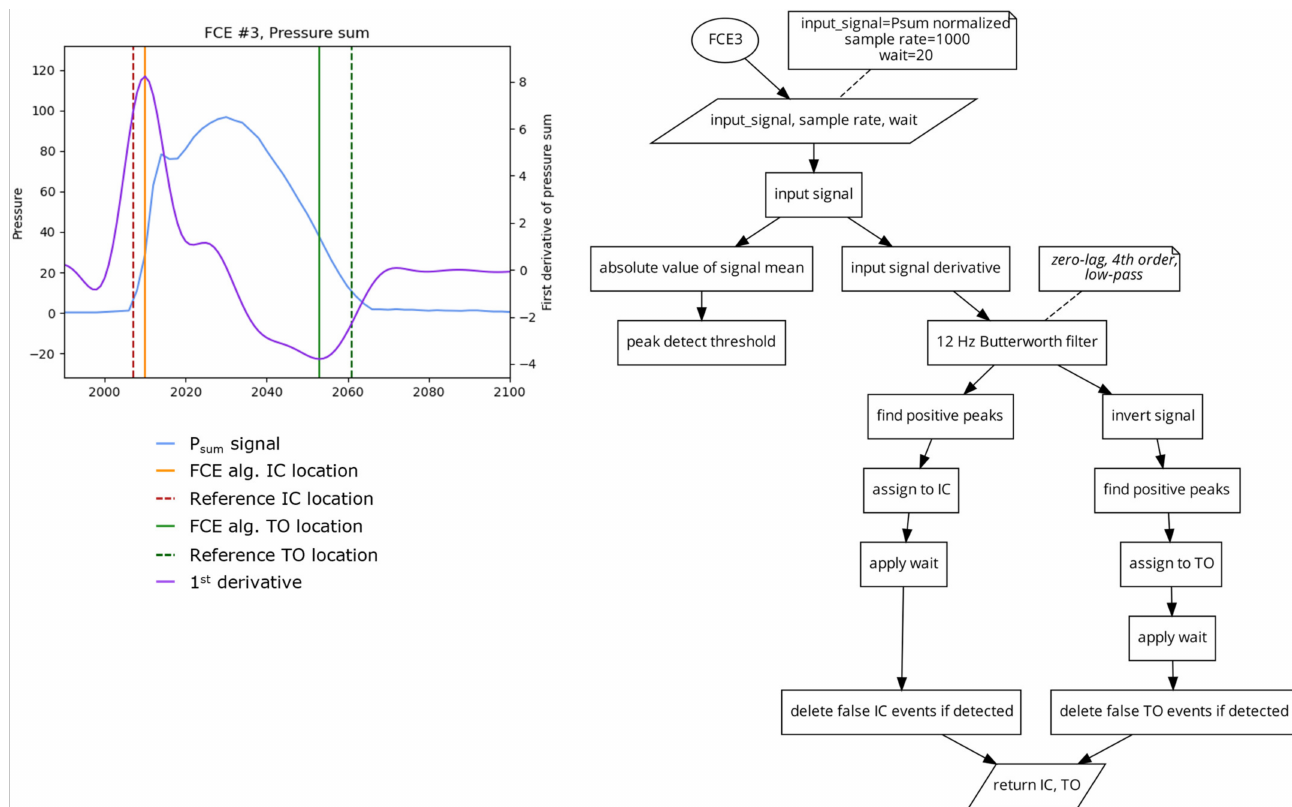
Figure 6. Plot ( left ) displaying a single stride and the location of the reference FCEs (dashed vertical) and the FCEs (solid vertical), as determined by the FCE3 algorithm ( right